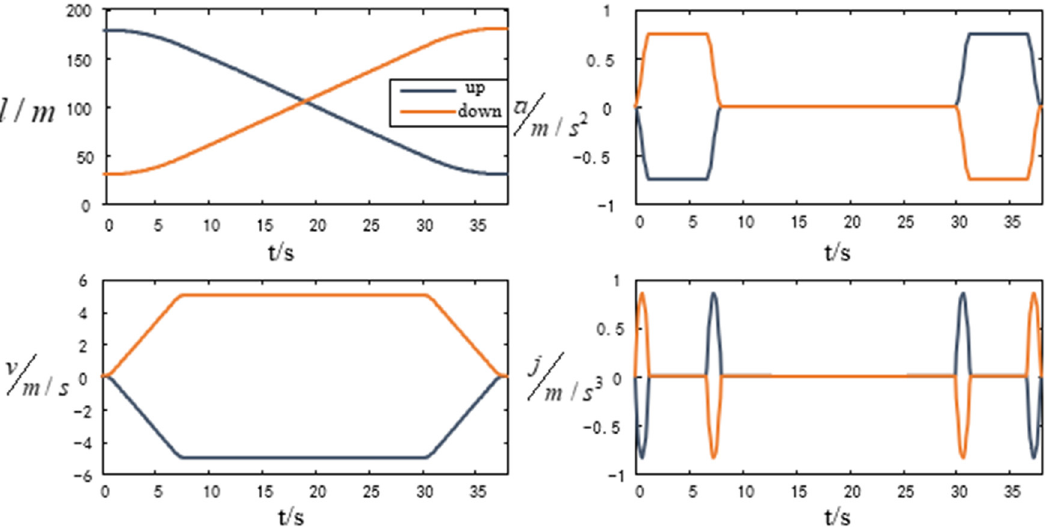
Fig. 3. Elevator running state